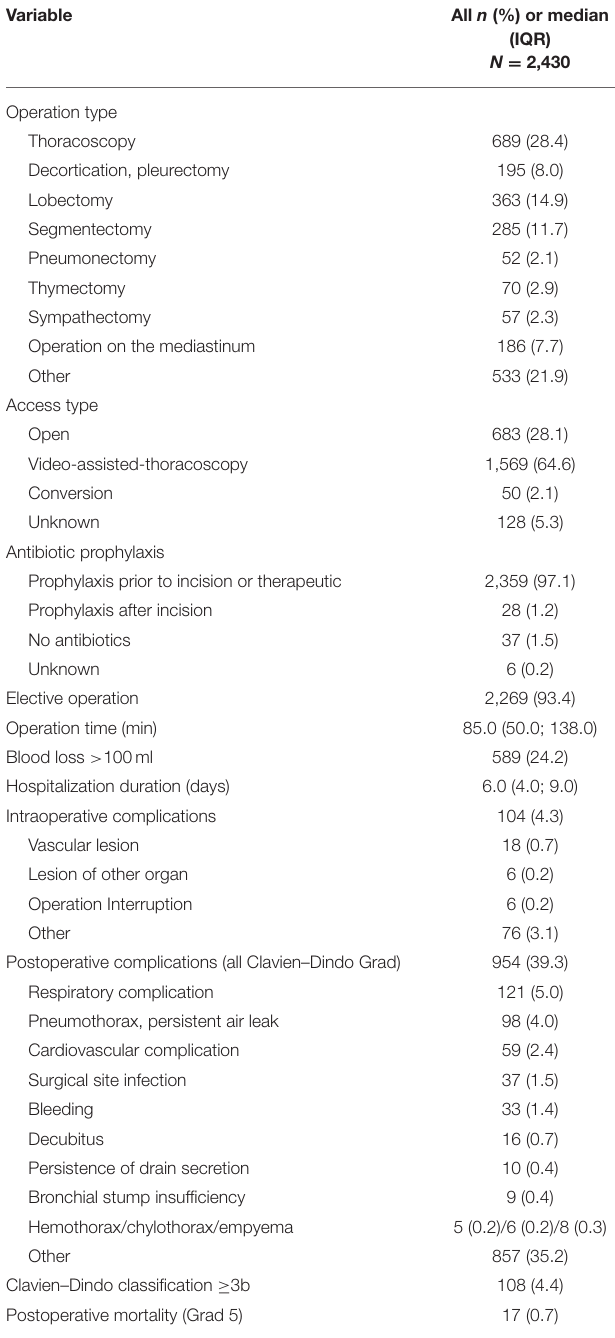
TABLE 2 | Perioperative characteristics of 2,430 patients undergoing a thoracic surgery. Variable